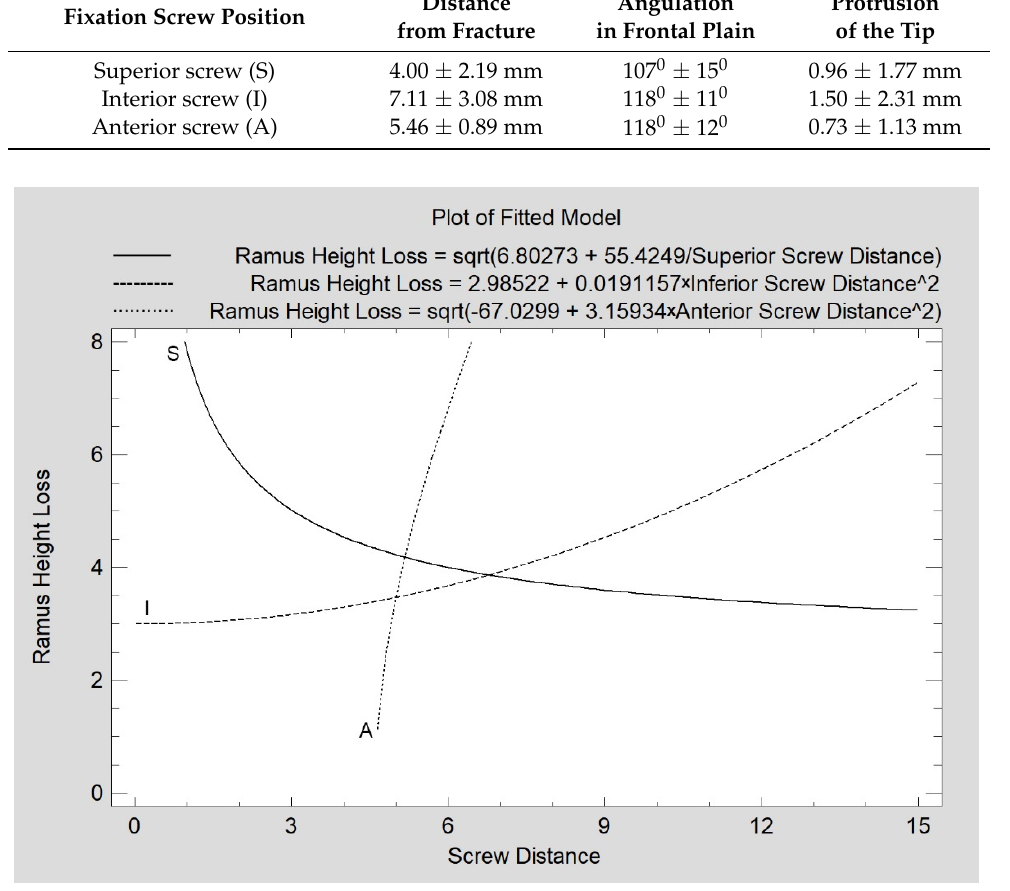
Figure 6. Relationship of mandibular ramus height loss (mm) measured 12 months post-operationally with the distance of the inserted screw from the fracture line (mm). All relationships are statistically significant ( p < 0.05). S—superior screw; I—inferior screw; A—anterior screw.